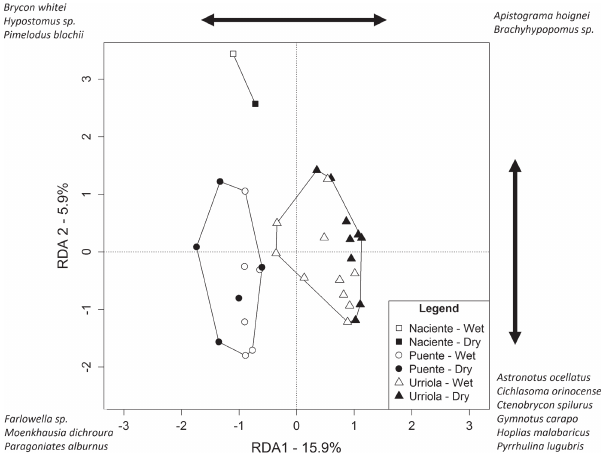
Fig. 3. RDA ordination plot for species assemblages at three si- tes along the longitudinal gradient of Caño Maraca during dry and wet seasons. Arrows indicate gradients contrasting species with highest positive and negative loadings on each